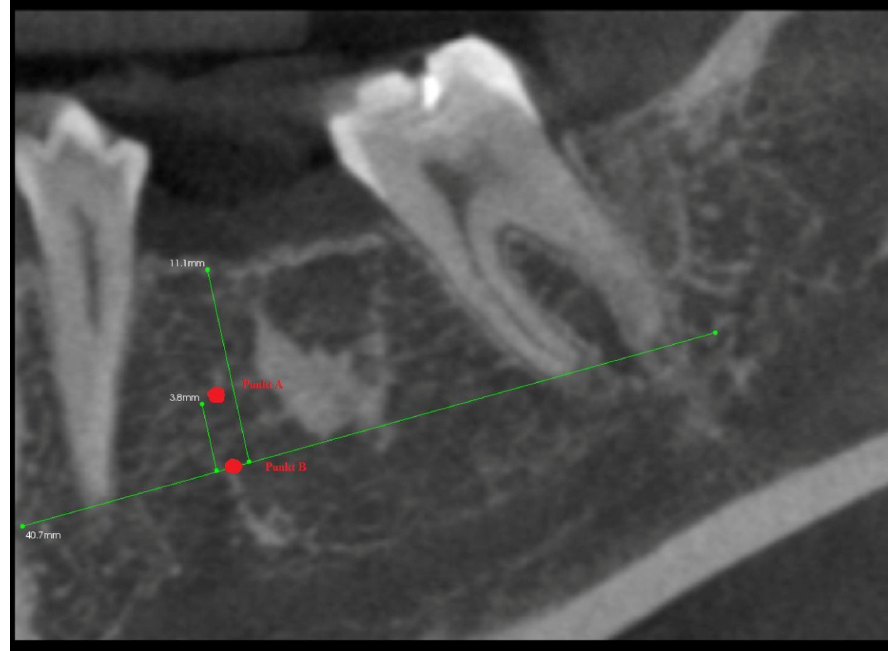
Figure 9. Longitudinal imaging of mandibular alveolus in CBCT. Grayscale value measurement 6 months post-extraction.